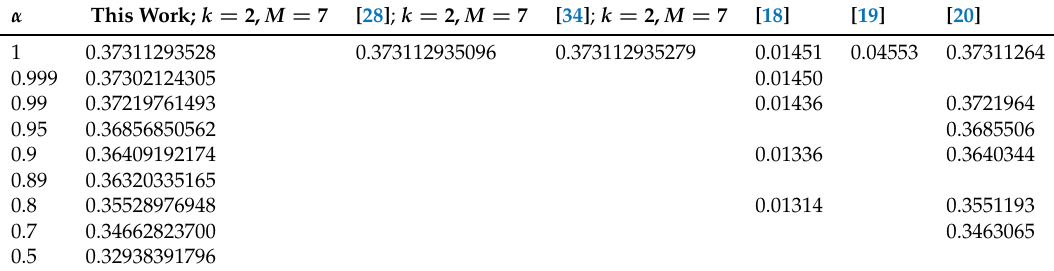
Table 1. Comparison of J ∗ for 0.5 ≤ α ≤ 1, Example 1.